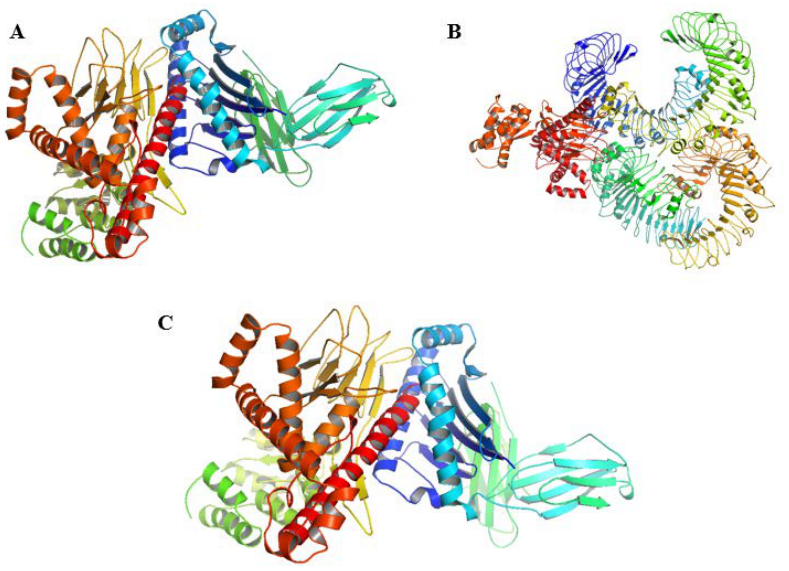
Figure 7. ( A ) Docking complex of MHC-1 with the vaccine, ( B ) docking complex of TLR2 with the vaccine, ( C ) docking complex of GRP78 with the vaccine.